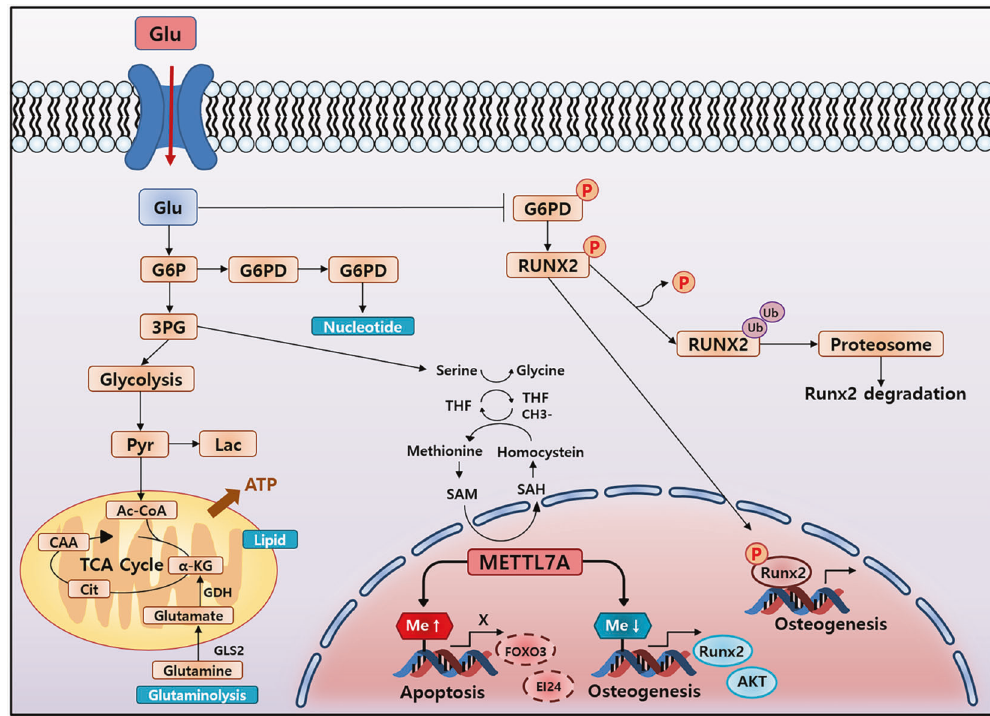
Fig. 7 A schematic illustrating the novel relationship between genes that induce bone regeneration in human bone marrow stem cells transfected with METTL7A genes. The METTL7A gene is shown to induce bone regeneration by regulating the methylation of genes involved in osteogenic differentiation and cell